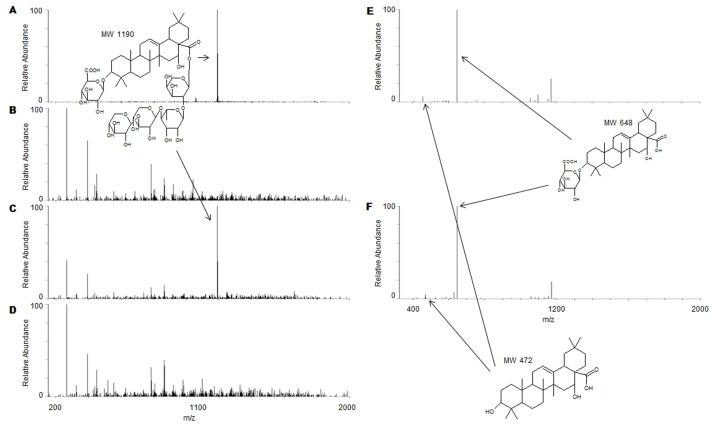
Mass spectrometry analysis of LAN-A interaction with Akt.(A) Electrospray ionization mass spectrometry (ESI-MS) of LAN-A standard shown. LAN-A molecular is shown to reside at MW 1190. ESI-MS analysis of IP Akt samples from untreated (B) LAN-A treated (C) A549 cells are shown. (D) ESI-MS analysis of IP β-actin from LAN-A treated cells is shown. (E) Tandem MS/MS analysis of LAN-A shows the two previously identified fragments Lancemaside X (MW 648) and echinocystic acid (MW 472) for LAN-A [32]. (F) Tandem MS/MS analysis for IP Akt sample from LAN-A treated cells.